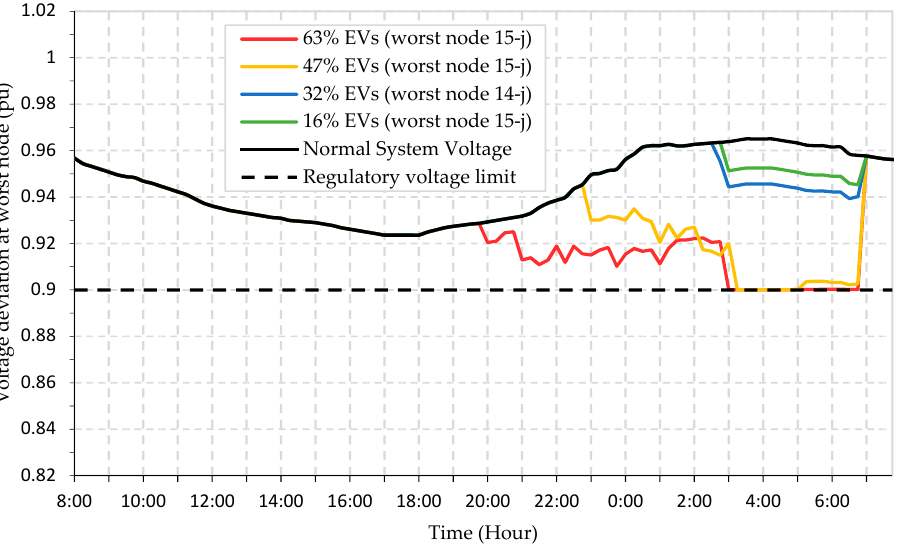
Figure 13. Impact of coordinated EVs’ charging with optimal starting time on voltage at worst nodes.